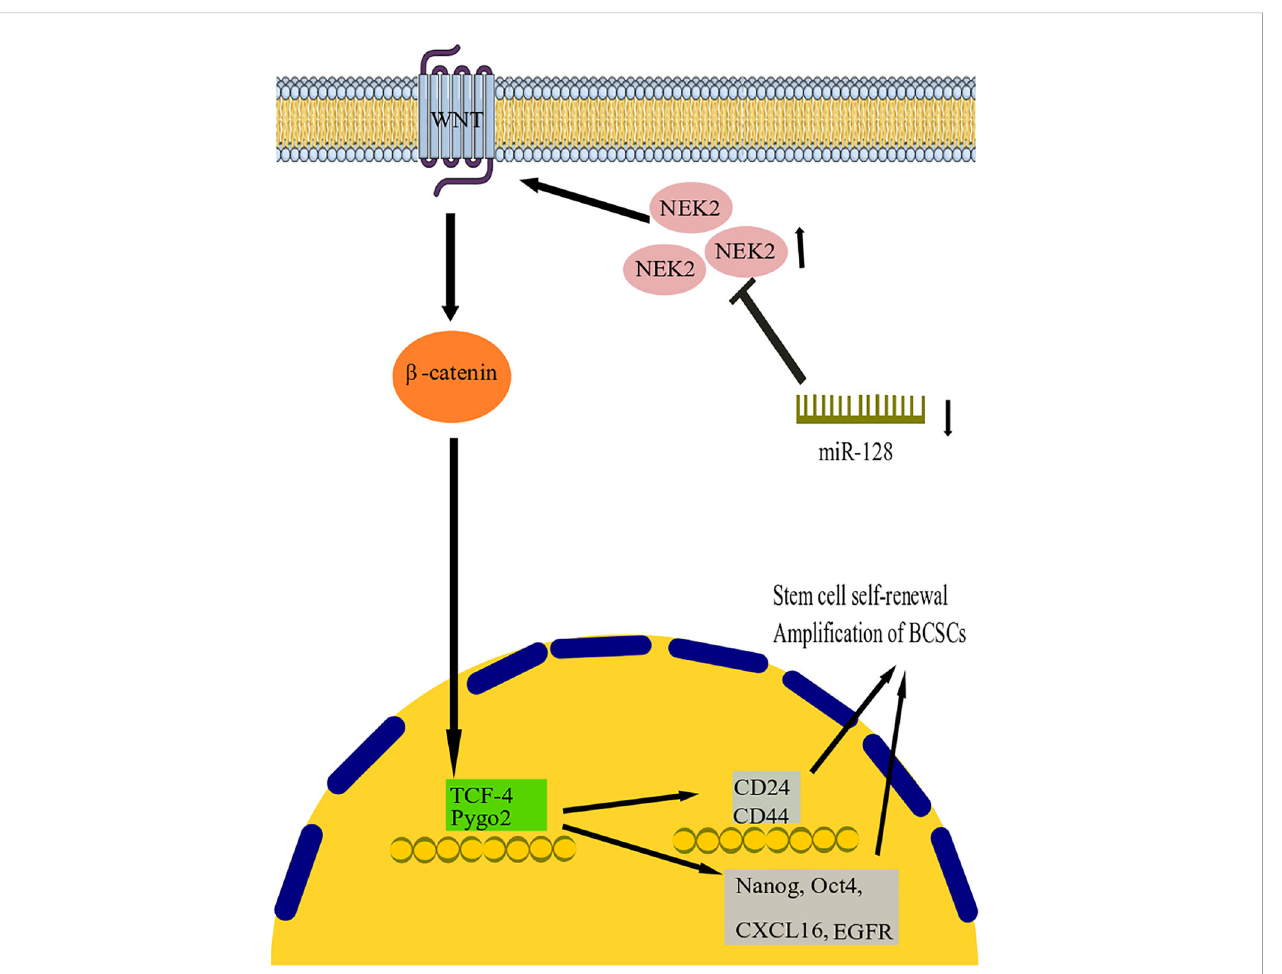
FIGURE 2 miR-128 action mechanism in breast cancer. It has been found that by reducing NEK2 expression, miR-128 can reduce stem cell properties such as division, motility, invasion, and self-renewal in BC stem cells (BCSCs). The study shows that overexpression of miR-128 reduced BCSC development, motility, and invasion by downregulating the Wnt signaling pathway by downregulating NEK2 expression. miR-128, microRNA-128; BCSCs, Breast cancer stem cells; NEK2, NIMA-related kinase 2; TCF4, transcription factor